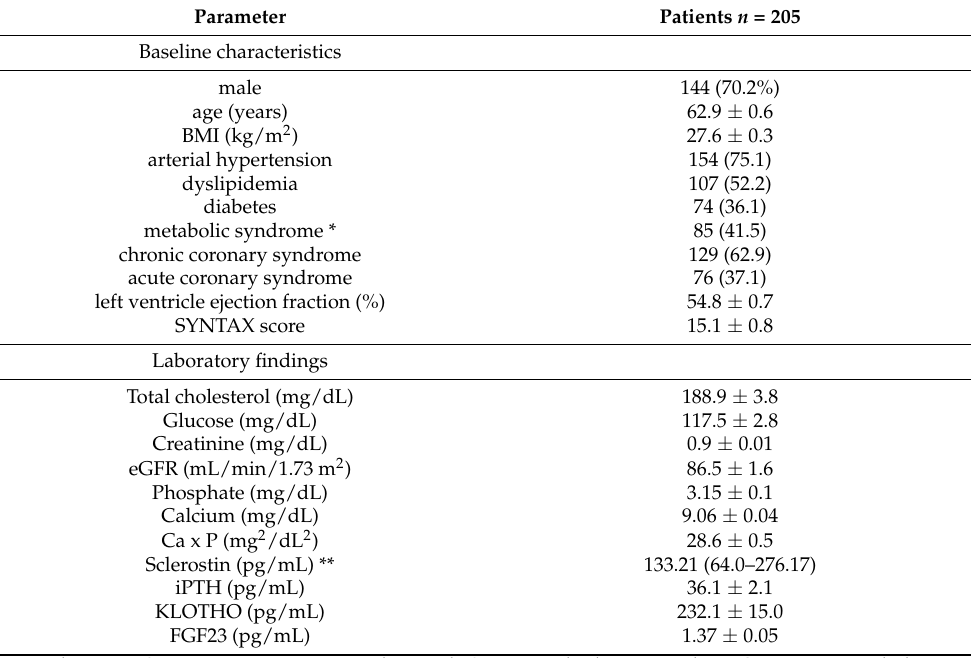
Table 1. Baseline characteristics and laboratory findings.